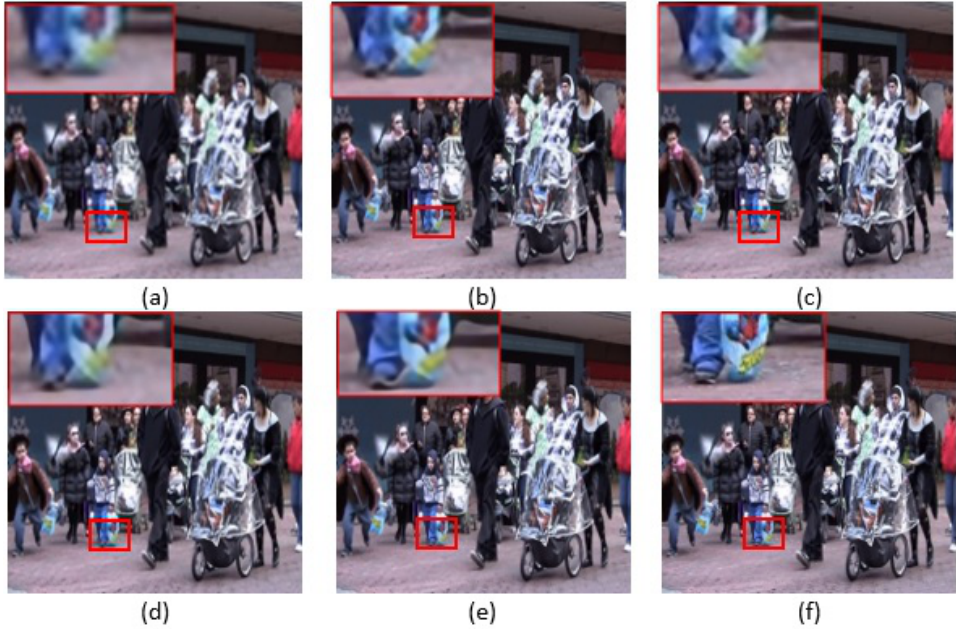
Figure 6. Qualitative comparison between VSR results obtained by ( a ) Bicubic, ( b ) VSRNET [24], ( c ) SRCNN [16], ( d ) VESPCN [27], ( e ) Proposed and ( f ) Ground-Truth on “ walk ” from Vid4 with scaling factor of x4.